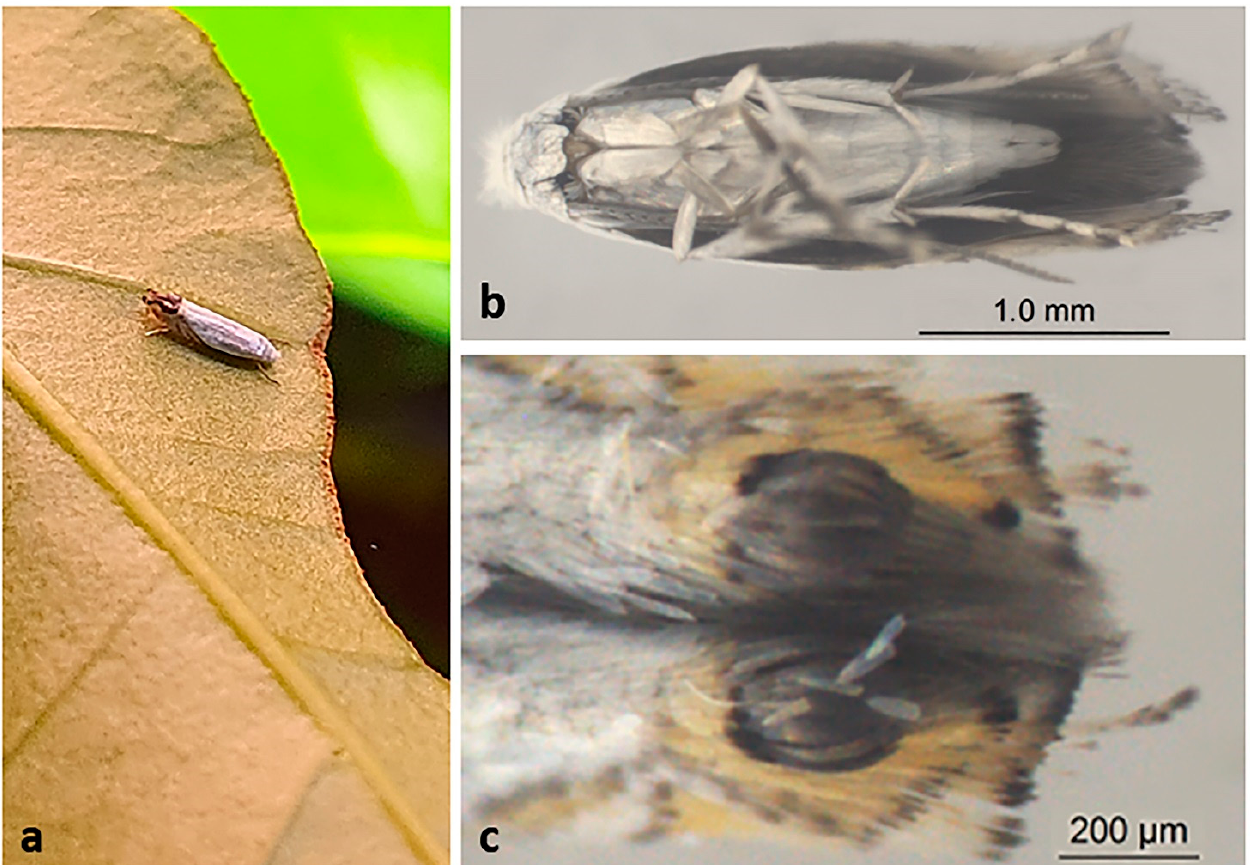
Figure 5. L. coffeella adults ( a ) perched on coffee leaf; ( b ) male seen by ventral view, with white scales all over the body; ( c ) closed caption of the wings apex from dorsal view to show details: black circle surrounded by yellow bristles.